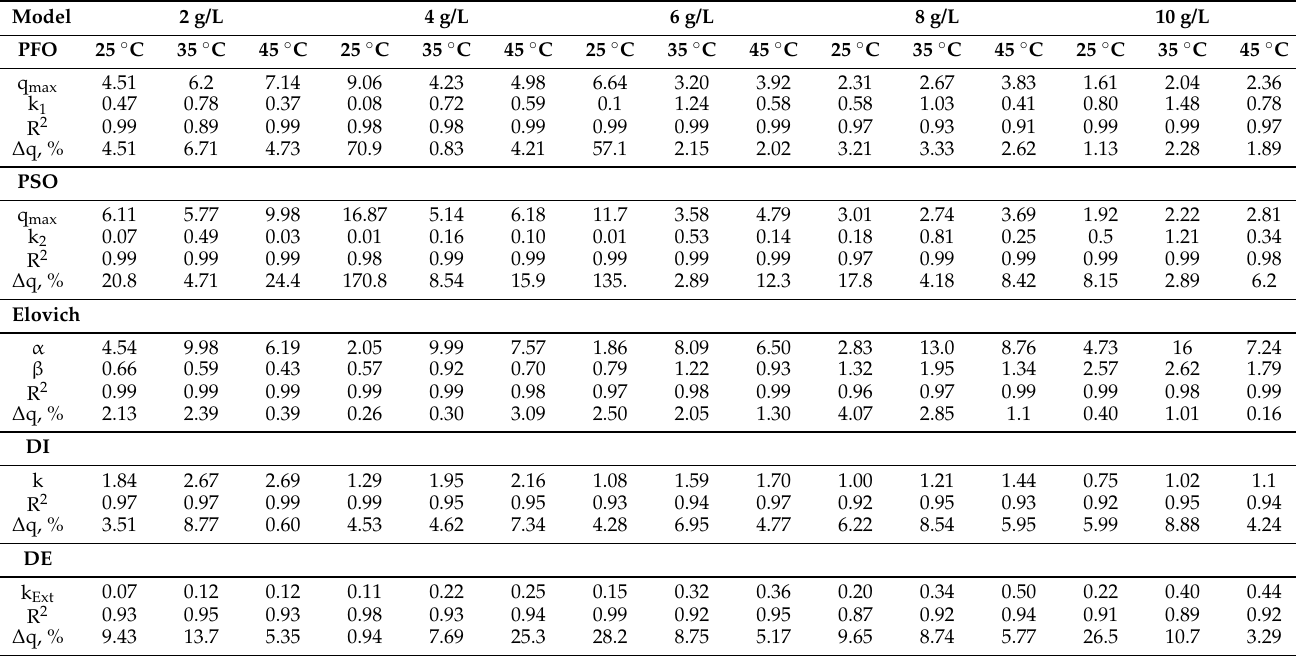
Table 5. Kinetic constant of DNS adsorption patterns in